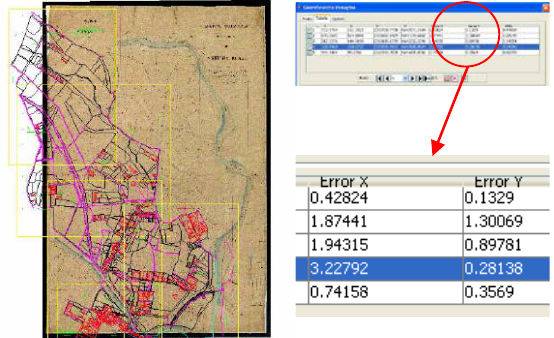
Figure 1. Geo-referencing of an historical map: on the right the discrepancies on check points expressed in pixel